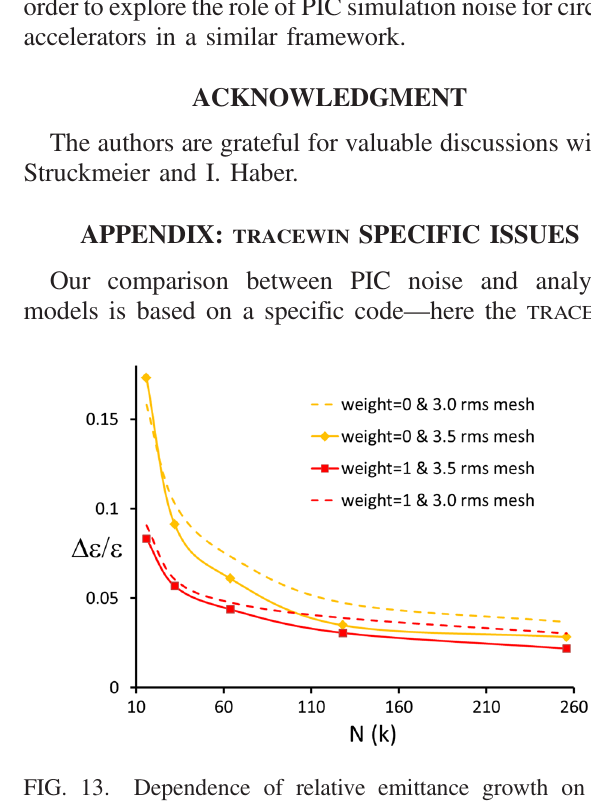
FIG. 13. Dependence of relative emittance growth on grid interpolation ( “ weight ¼ 0 = 1 ” corresponding to no/linear inter- polation) and mesh boundary (at 3 = 3 . 5 rms) as function of N (in units of